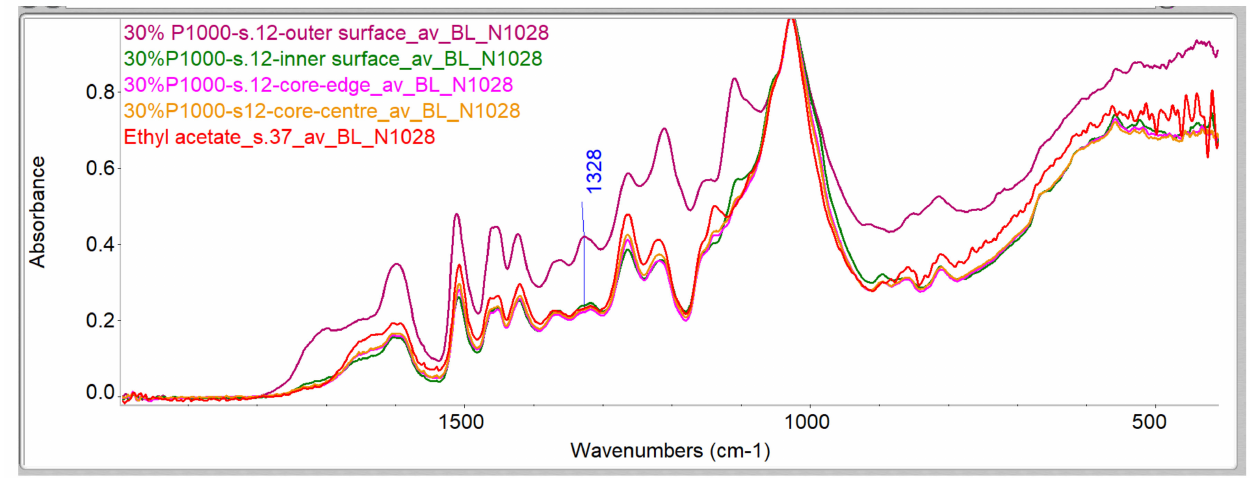
Figure 12. Comparing infrared spectra of 30% P1000-treated specimen 12 from different depths. Bands at 1328 cm − 1 were measured. The ethyl acetate-treated control is shown in the red curve (nr. 37). The image shows ‘outer surface’ (purple), ‘inner surface (green), ‘core edge’ (pink) and ‘centre core’ (orange). All spectra were baseline corrected and normalized to 1028 cm − 1